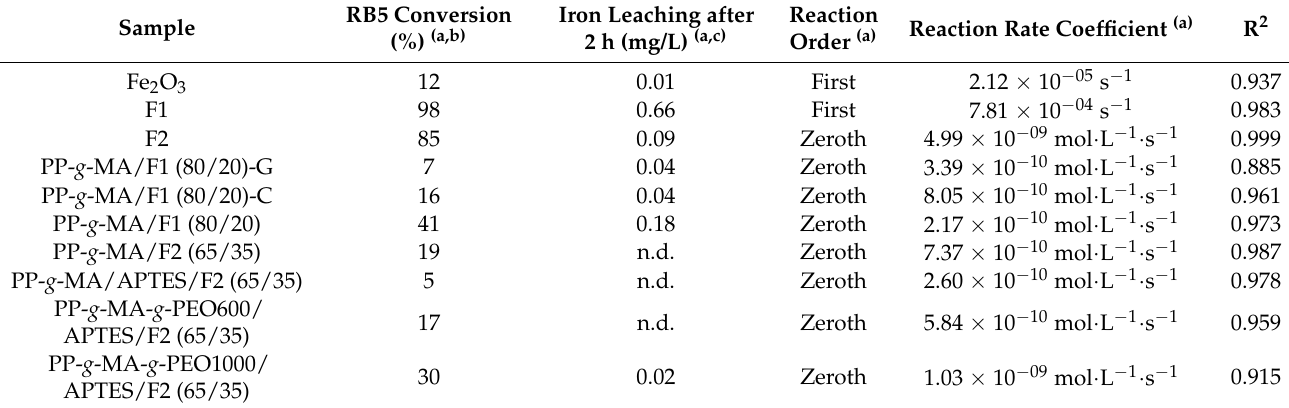
the iron leaching of PP- g -MA/F1 composites was drastically reduced compared to F1. Table 5. Kinetic parameters of the RB5 conversion catalyzed by Fenton polymer composites and iron leaching after 120 min.